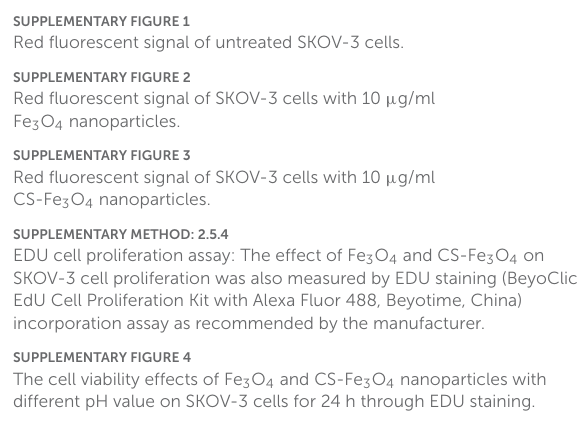
SUPPLEMENTARYMETHOD:2.5.4 EDU cell proliferation assay: The effect of Fe 3 O 4 and CS-Fe 3 O 4 on SKOV-3 cell proliferation was also measured by EDU staining (BeyoClick EdU Cell Proliferation Kit with Alexa Fluor 488, Beyotime, China) incorporation assay as recommended by the